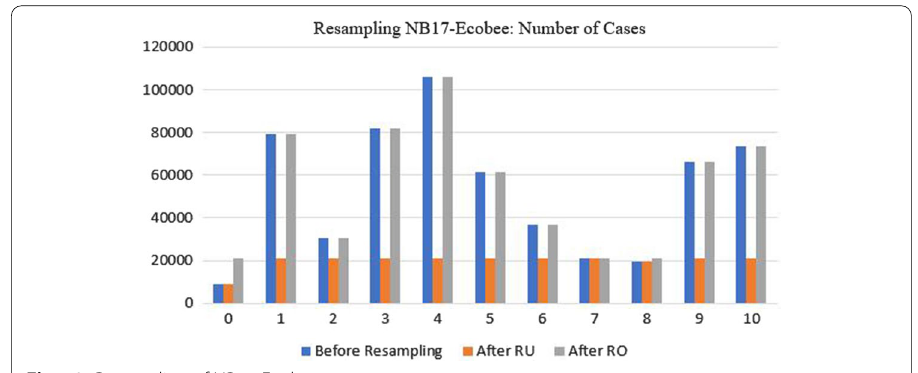
Fig. 12 Resampling of NB17-Ecobee